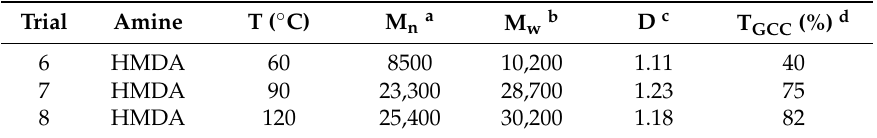
Table 2. One-pot strategy; influence of the temperature on the synthesis of glycerol amino ethylene ester PHUs. Duration = 2